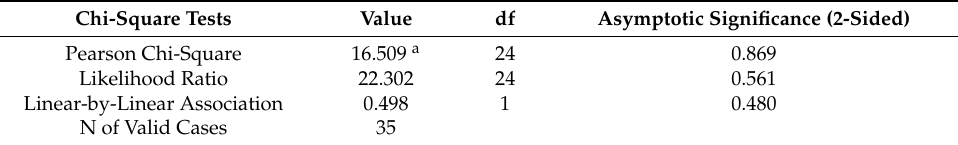
Table A3. Chi-square tests: Game * Age.